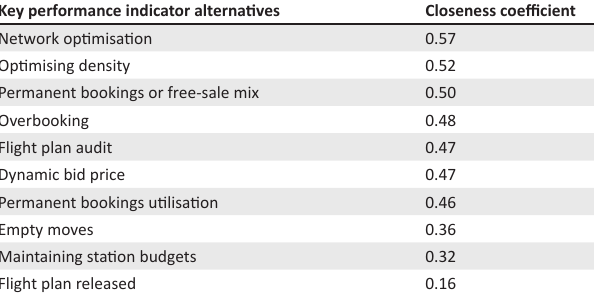
TABLE 3: Aggregated ranking of outcome-based key performance indicator alternatives. Key performance indicator